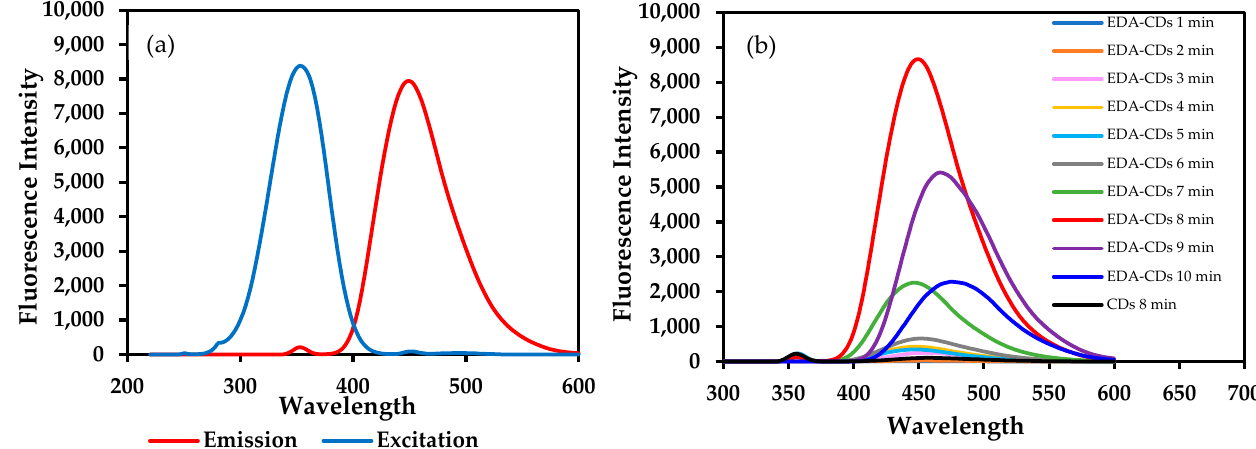
Figure 1. ( a ) Excitation spectrum and fluorescence emission spectrum of the EDA-CDs (300 W, 8 min) and ( b ) fluorescence emission spectra of the EDA-CDs from different exposure times, ranging from 1–10 min (300 W).